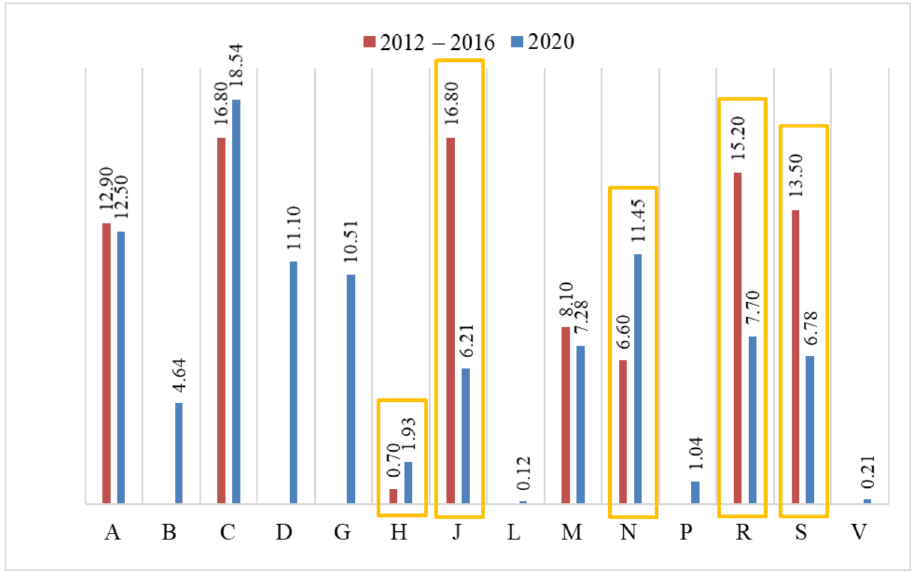
Figure 2. Medicines prescribed by pharmacists according to the ATC Classification System in the Kuyavian-Pomeranian Voivodeship from 2002 to 2016 and from 1 April to 30 October